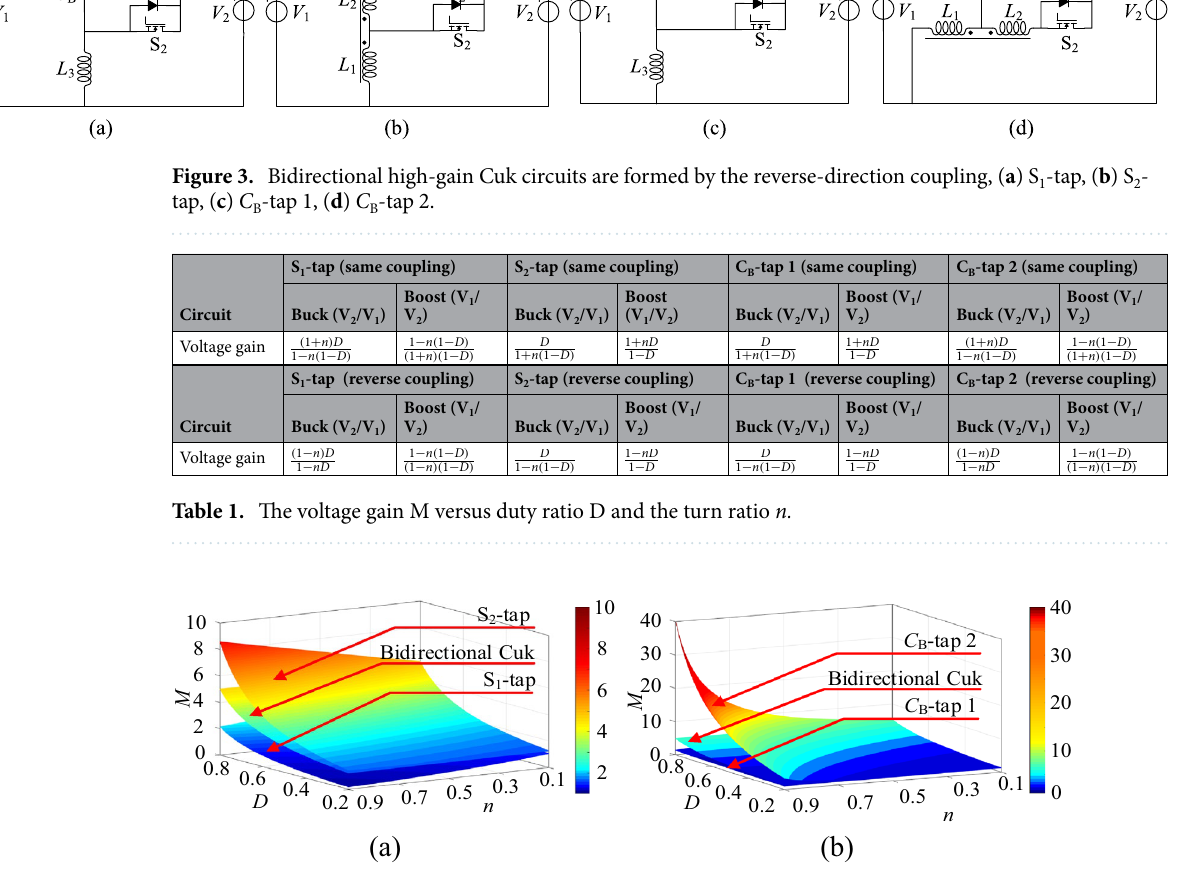
Figure 4. The voltage gain characteristic curves of the eight circuits in the step-up mode, ( a ) the same-direction coupling, ( b ) the reverse-direction